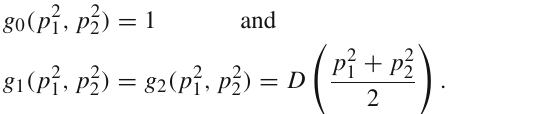
For completeness, we write the full expressions for the lon- gitudinal form factors in Euclidean